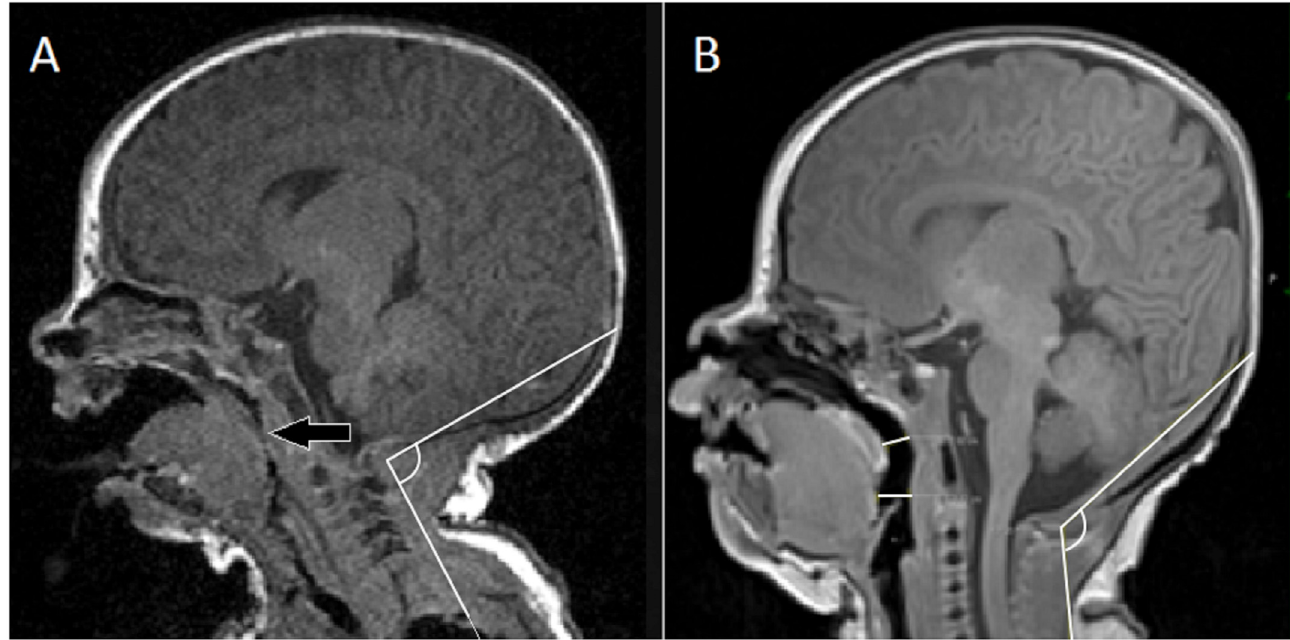
Fig 2. A — Sagittal T1-weighted MR image of head-neck region of a newborn-infant showing obstructed airway at the tongue level. B — Sagittal T1-weighted MR image of head-neck region of a newborn-infant showing a patent airway.